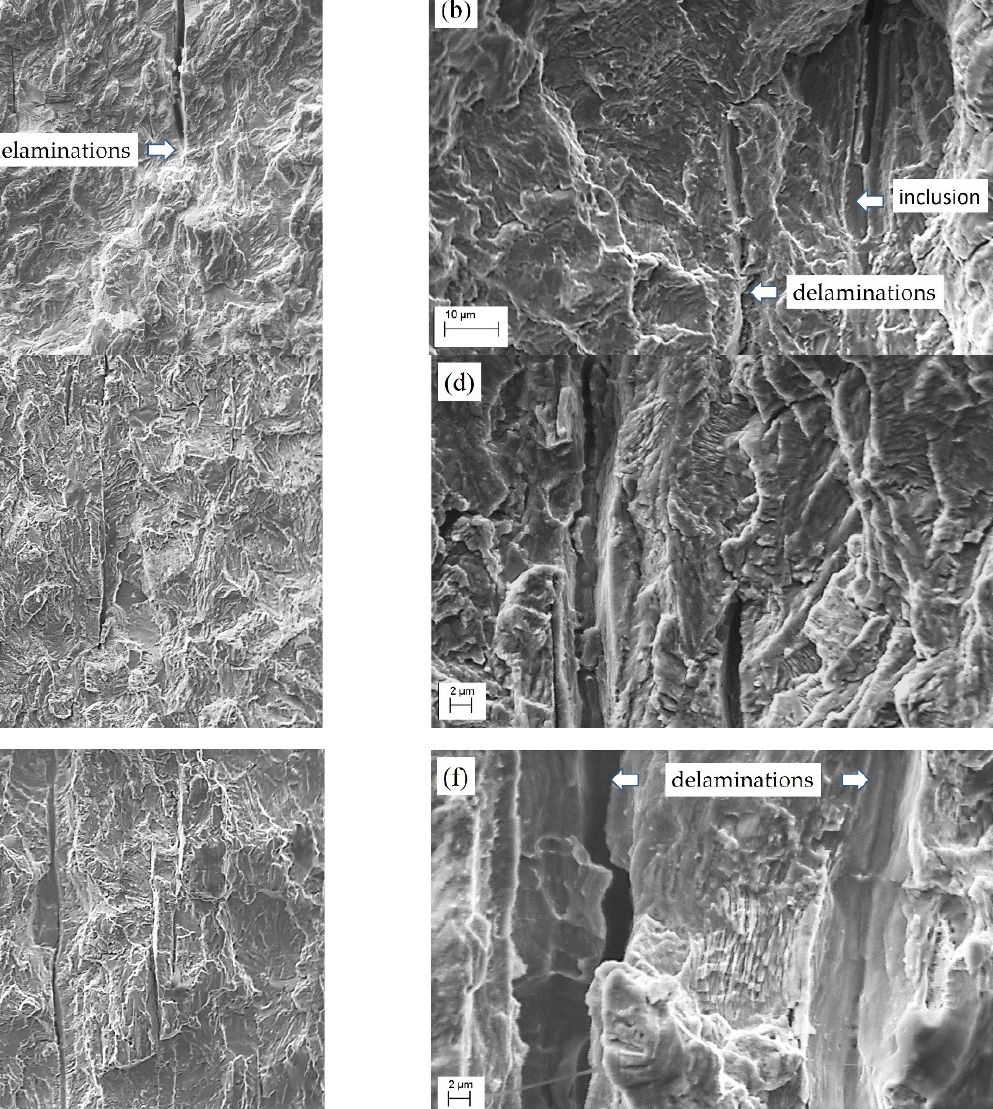
Figure 11. SEM fractography of specimens of 17H1S steel ( a , b ) in the AR state and ( c – f ) after LTO cut from the upper ( c , d ) and lower ( e , f ) parts of the corresponding pipe in the positions close to its inner surface and undergoing the FCG resistance test at a frequency of 10 Hz and a stress ratio of 0.5. The SEM images correspond to the Δ K level of about 32–35 MPa m 1/2 . Cleavage, inclusion and delaminations are indicated by arrows.